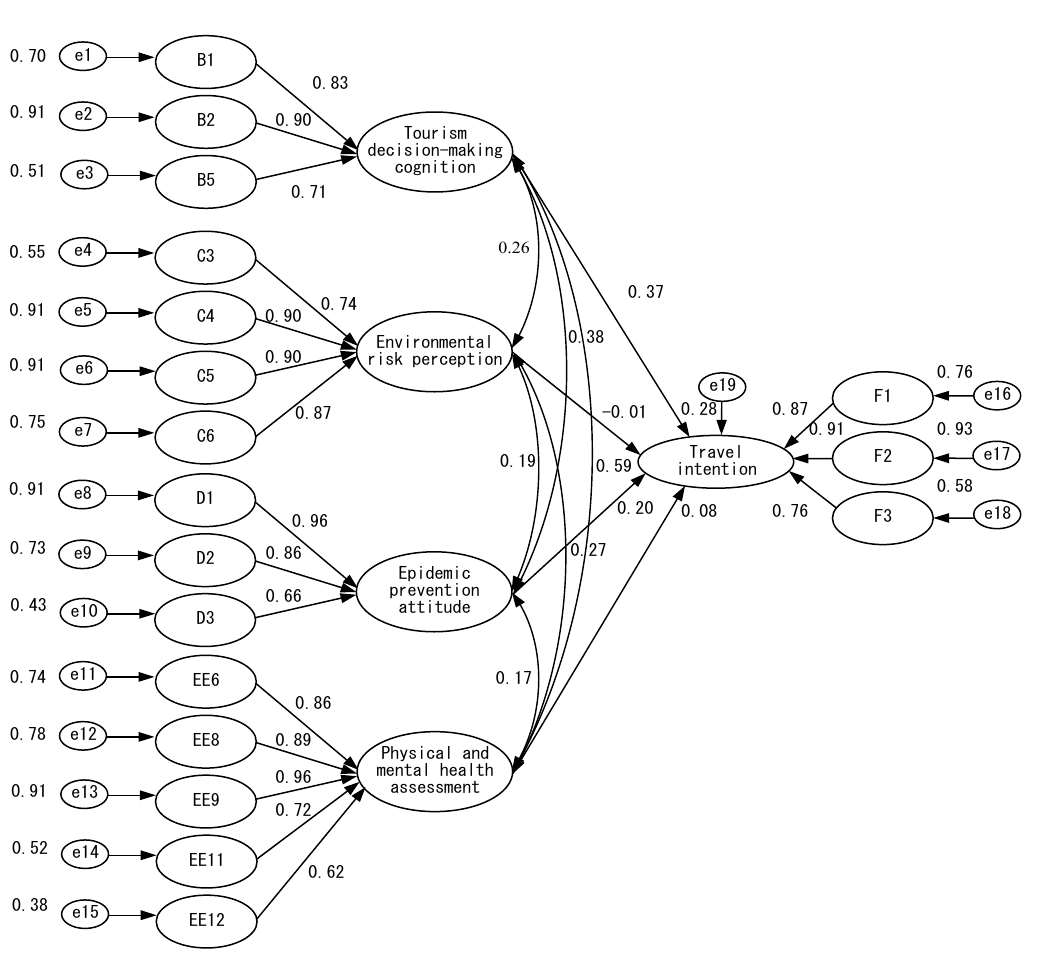
Figure 7. The model of travel intention. Table 6. Study hypotheses and validation results.